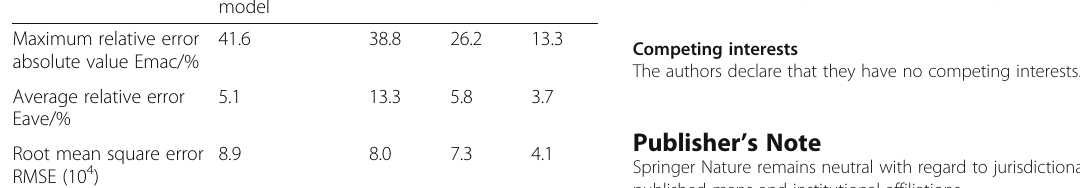
Table 1 Prediction error of different models